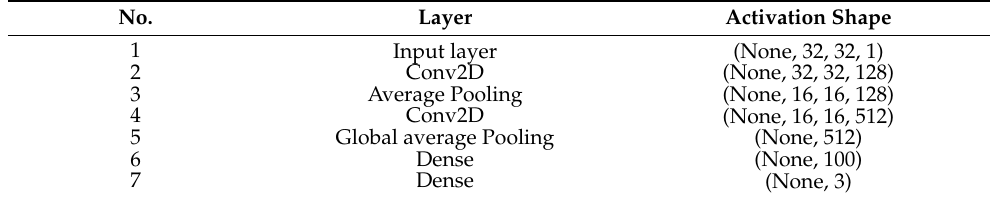
Table 4. The structural parameters of CNN.